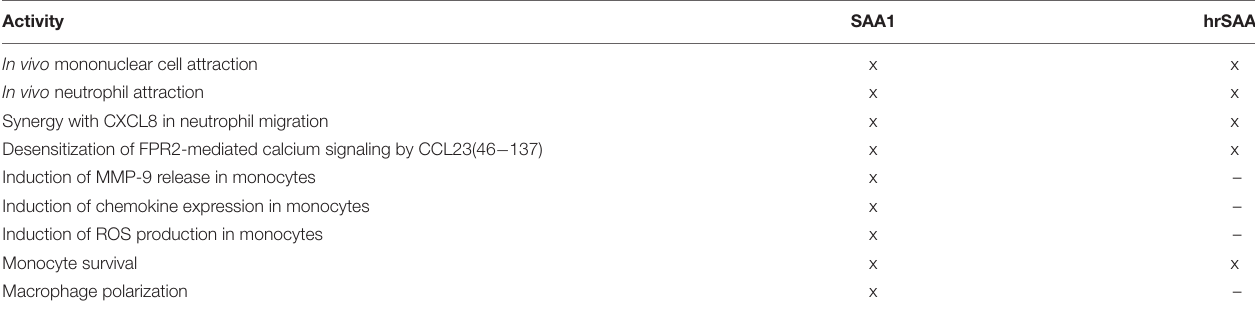
TABLE 1 | Comparison of the biological activities of E. coli -expressed SAA1 before (SAA1) and after (hrSAA1) purification to homogeneity using RP-HPLC. Activity SAA1 hrSAA1 In vivo mononuclear cell attraction x x In vivo neutrophil attraction x x Synergy with CXCL8 in neutrophil migration x x Desensitization of FPR2-mediated calcium signaling by CCL23(46 − 137) x x Induction of MMP-9 release in monocytes x Induction of chemokine expression in monocytes Induction of ROS production in monocytes Monocyte survival Macrophage